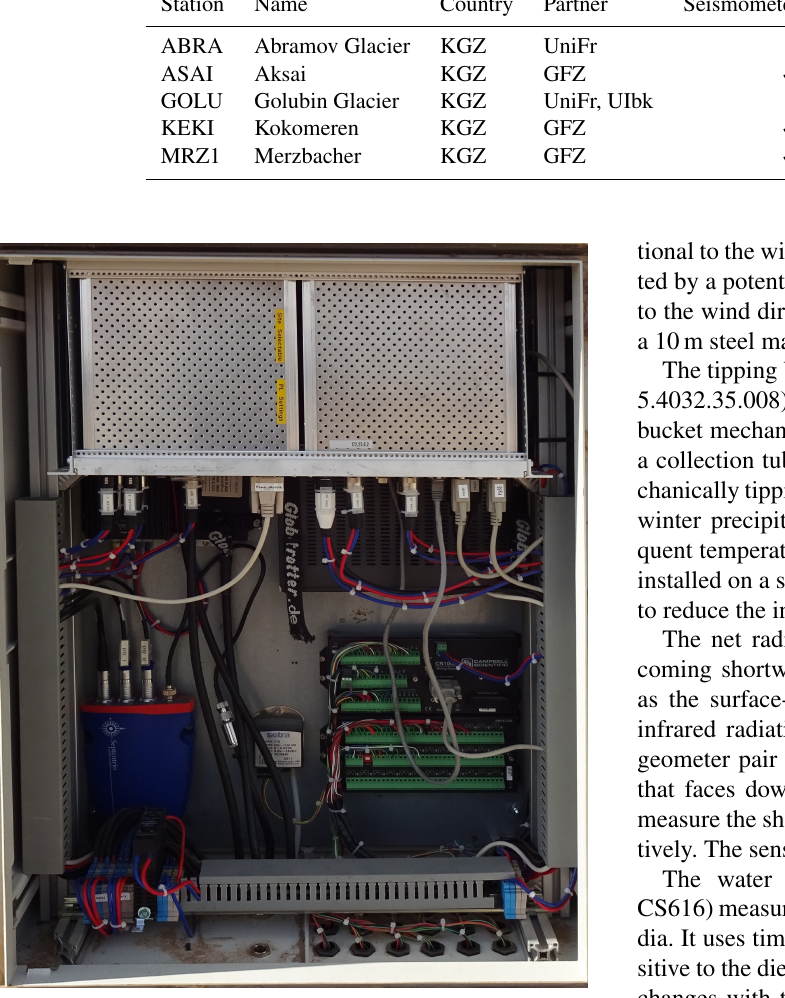
Figure 6. Station main box. Topside: the computer and power mod- ule is visible. The VSAT and Iridium modem are located at the back. Below is the GNSS receiver (left), the barometric sensor (middle) and the Campbell data logger (Schöne et al.,